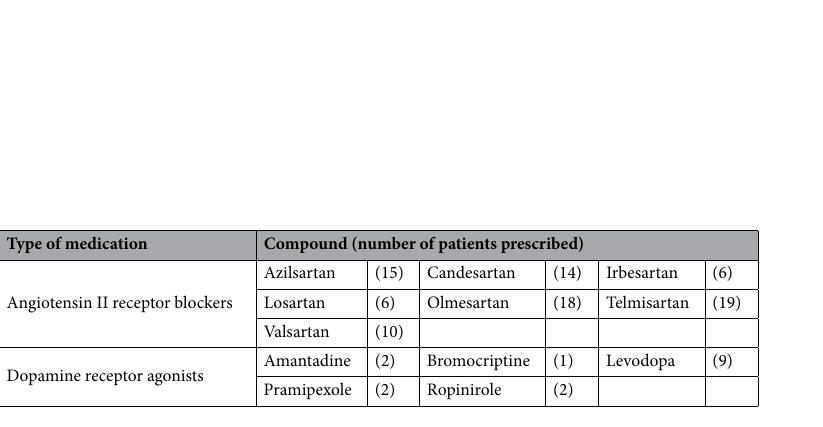
Table 3. Variables significantly associated with hallucinations in delirium. CI, confidence interval; BZD, benzodiazepine.